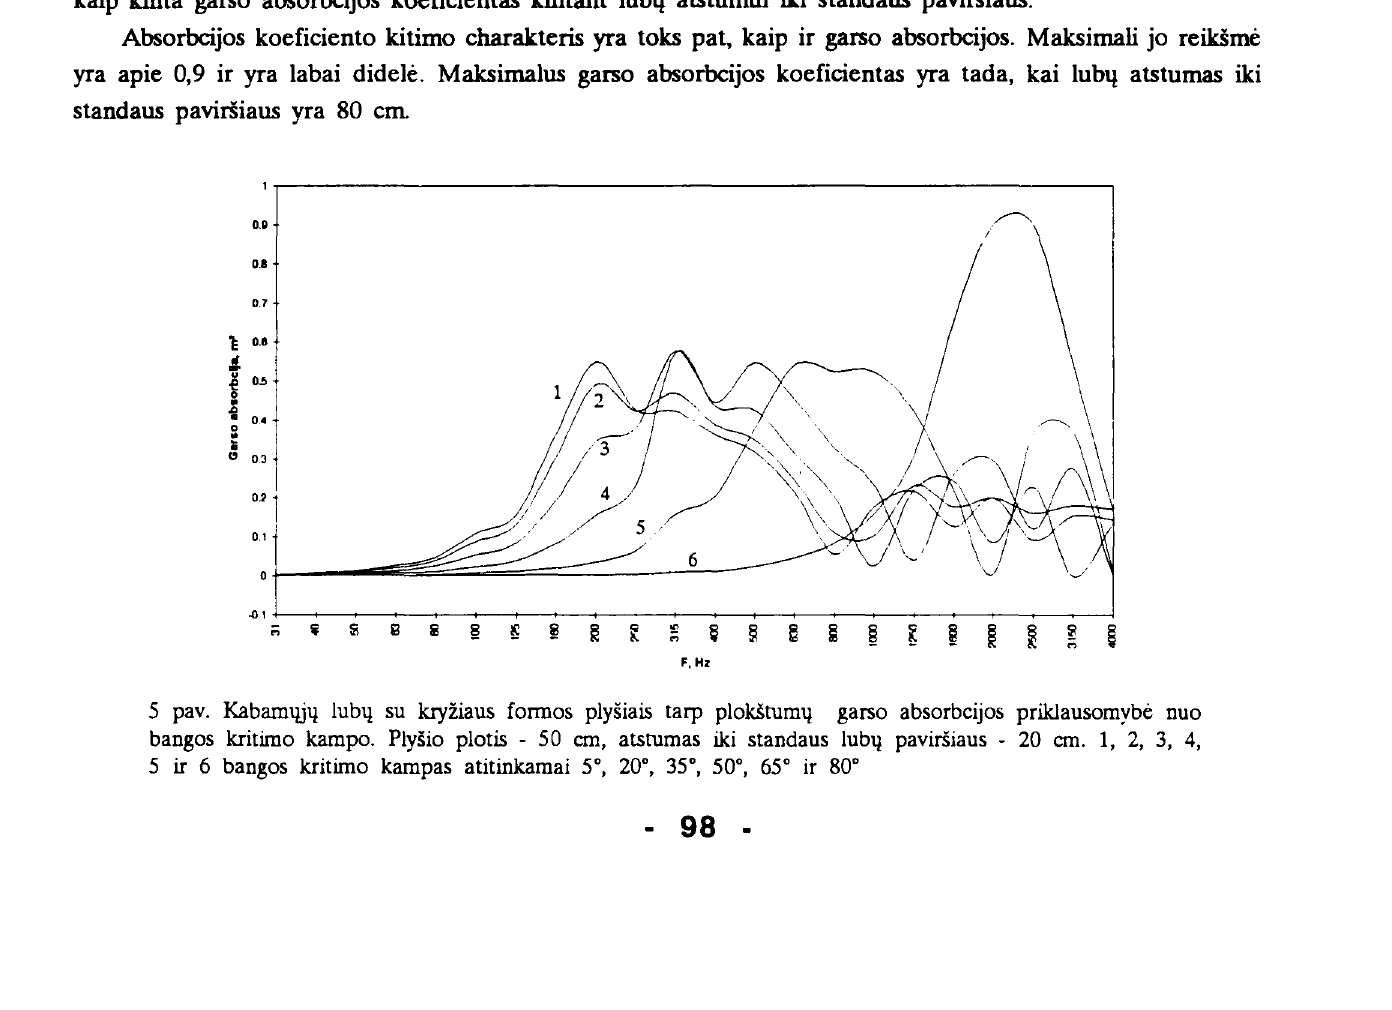
absorbcija yra net apie 700 m 2•